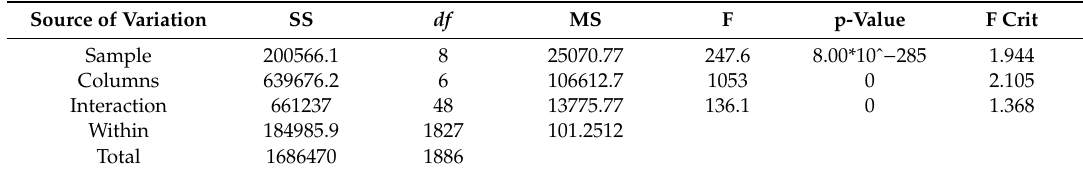
Table 8. ANOVA for upper and lower sectors